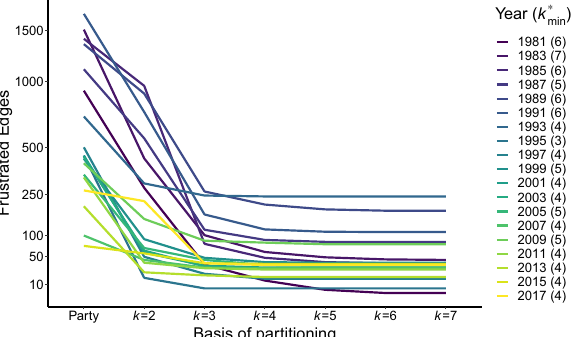
Figure 2. Number of frustrated edges (y-axis) of signed US House networks partitioned using different criteria (x-axis). Each line represents a single network, corresponding to a session of the US House starting in the given year. Fewer frustrated edges indicate that the partition is more consistent with the ties of collaboration and opposition between